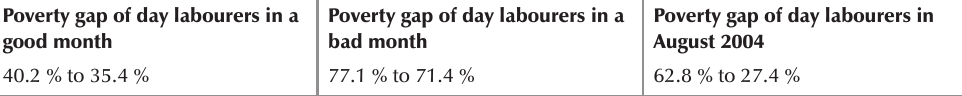
Poverty gap of day labourers supporting four dependents under various income scenarios